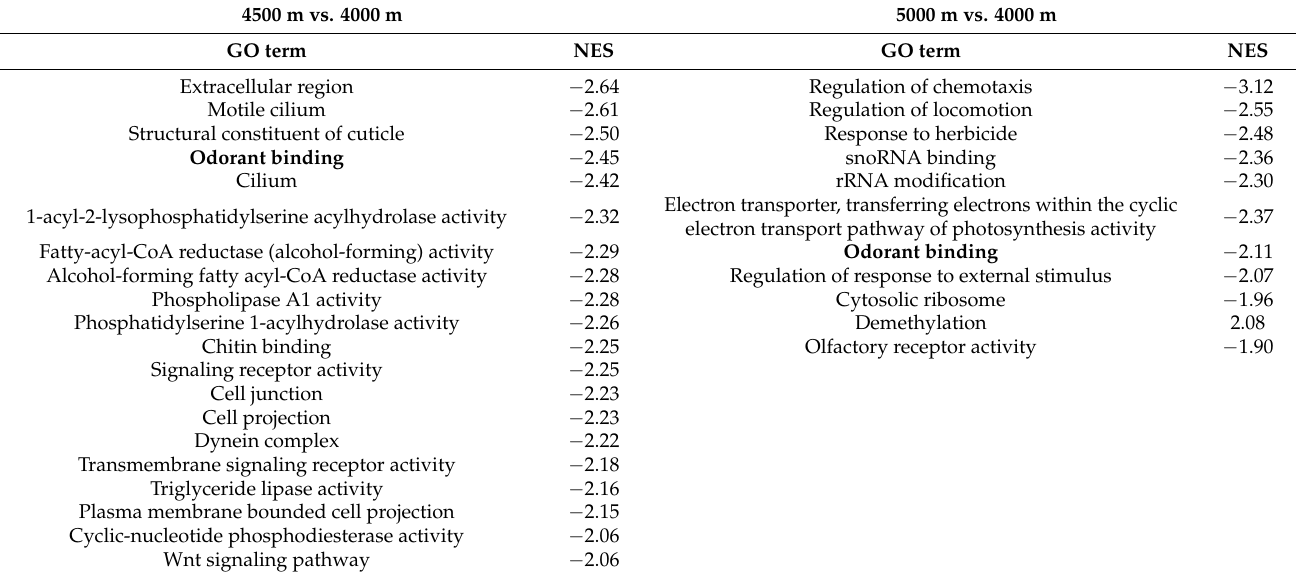
Table 3. Results of the gene set enrichment analysis for Bombus waltoni